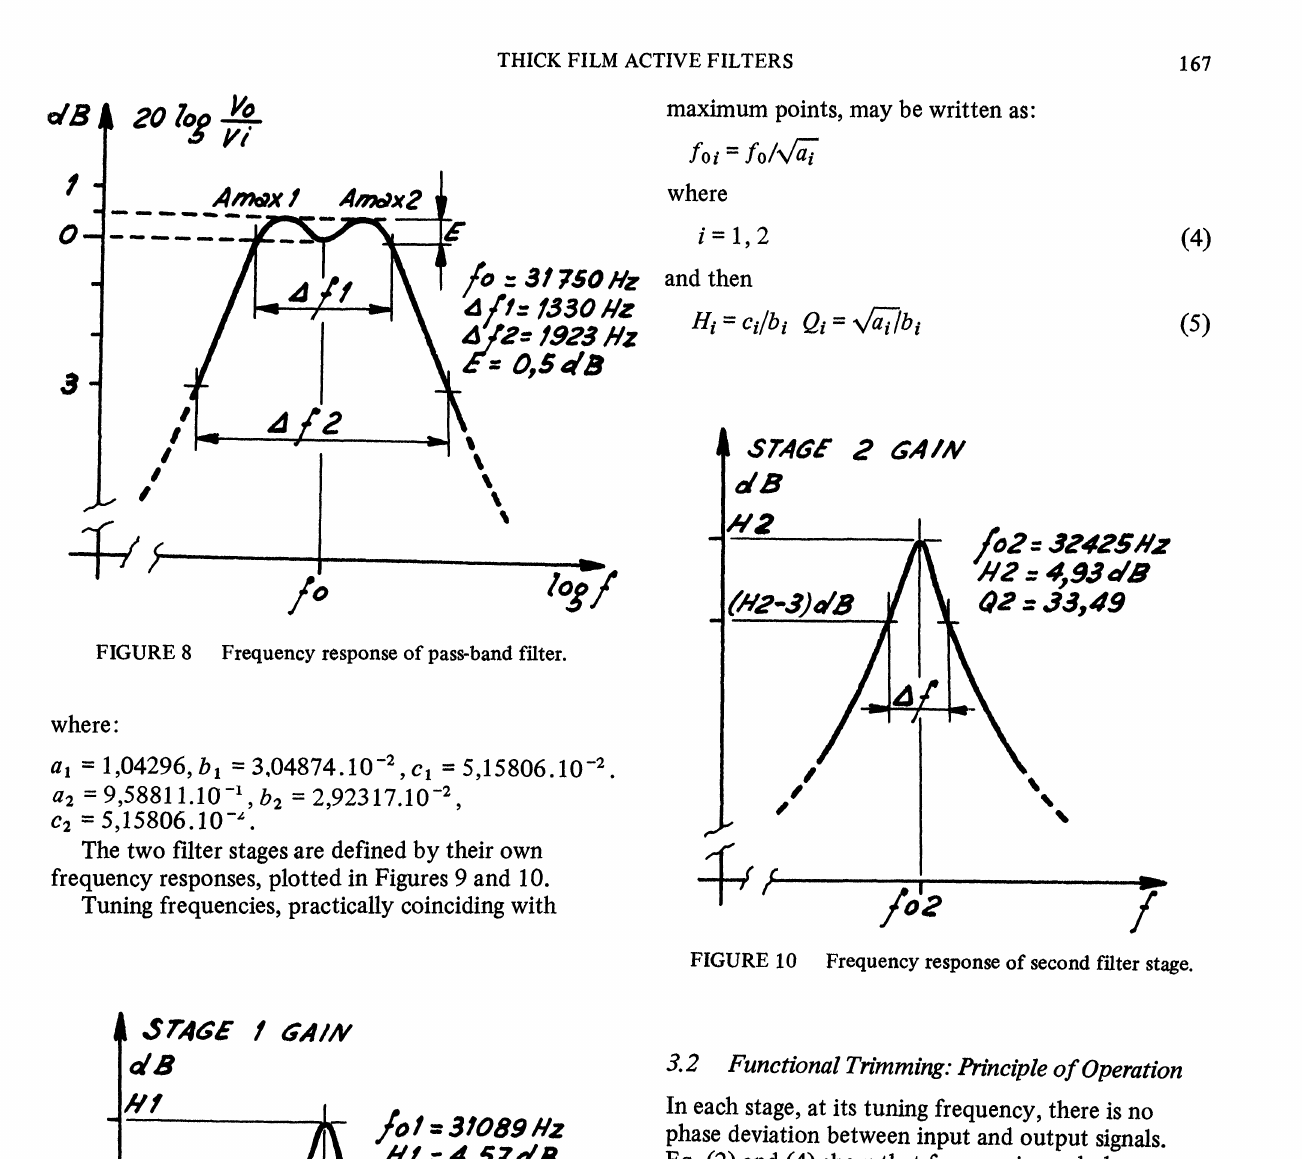
0I = 3/089 Hz = 3349